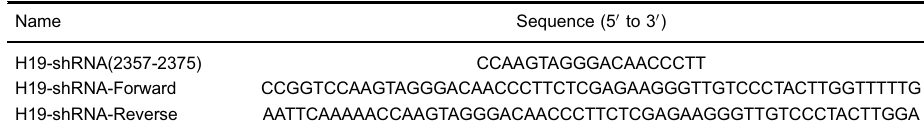
Table 2. lncRNA H19 interference sequences.